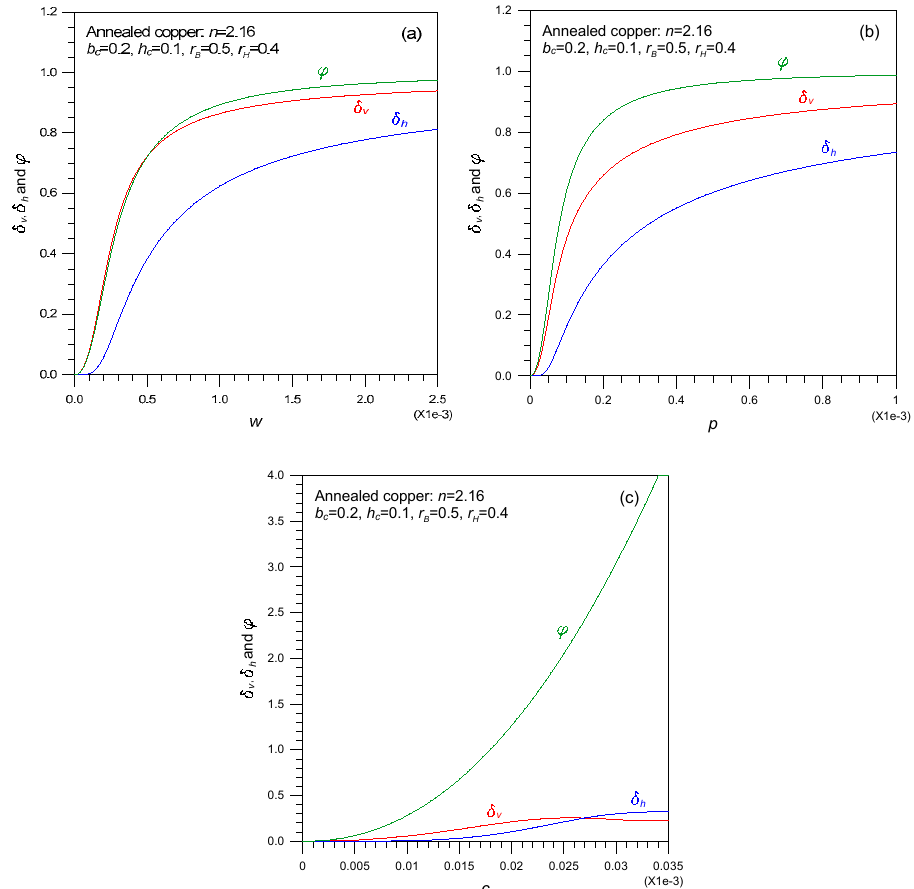
Figure 4. Tip responses of the beam under ( a ) uniform loading, ( b ) tip point loading, and ( c ) tip couple loading.